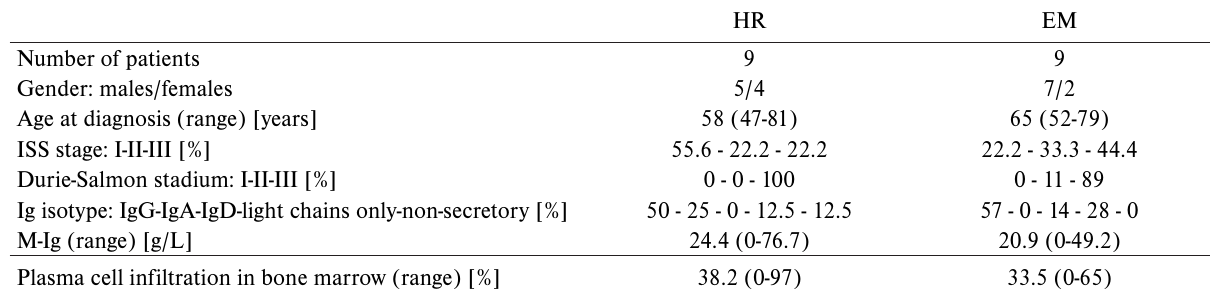
Table 1. Patients’